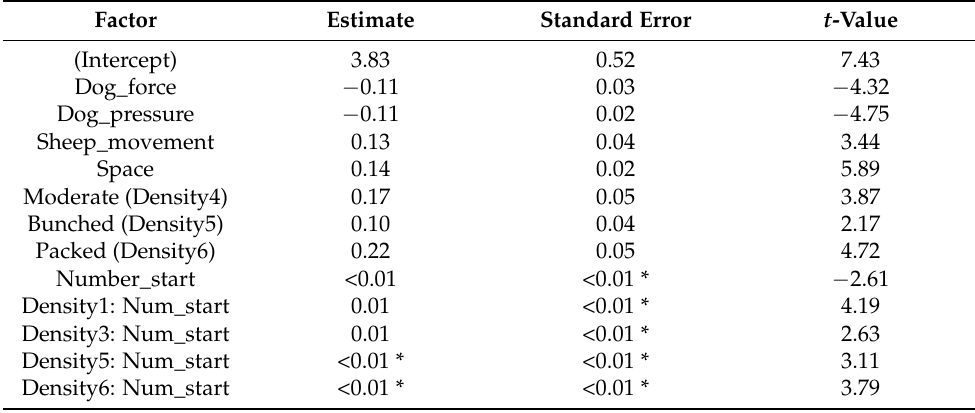
Table 4. Selected results of the linear mixed model examining factors affecting the rate of sheep movement per minute, showing only the statistically significant results. Reference level is Density = 2. Std Error is the Standard Error of the Estimate (S.E.). “*” represents statistically significant